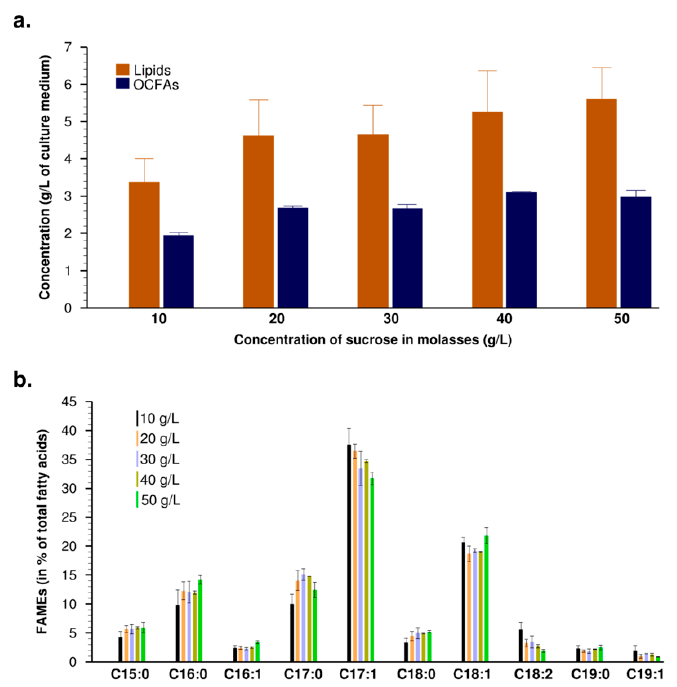
Figure 3. ( a ) Total lipid content in Y. lipolytica cultivated on different sucrose concentrations in sugar beet molasses (10–50 g/L), ( b ) lipid profiles obtained by GC-FID, depending on sucrose concentra- tion in sugar beet molasses (10–50